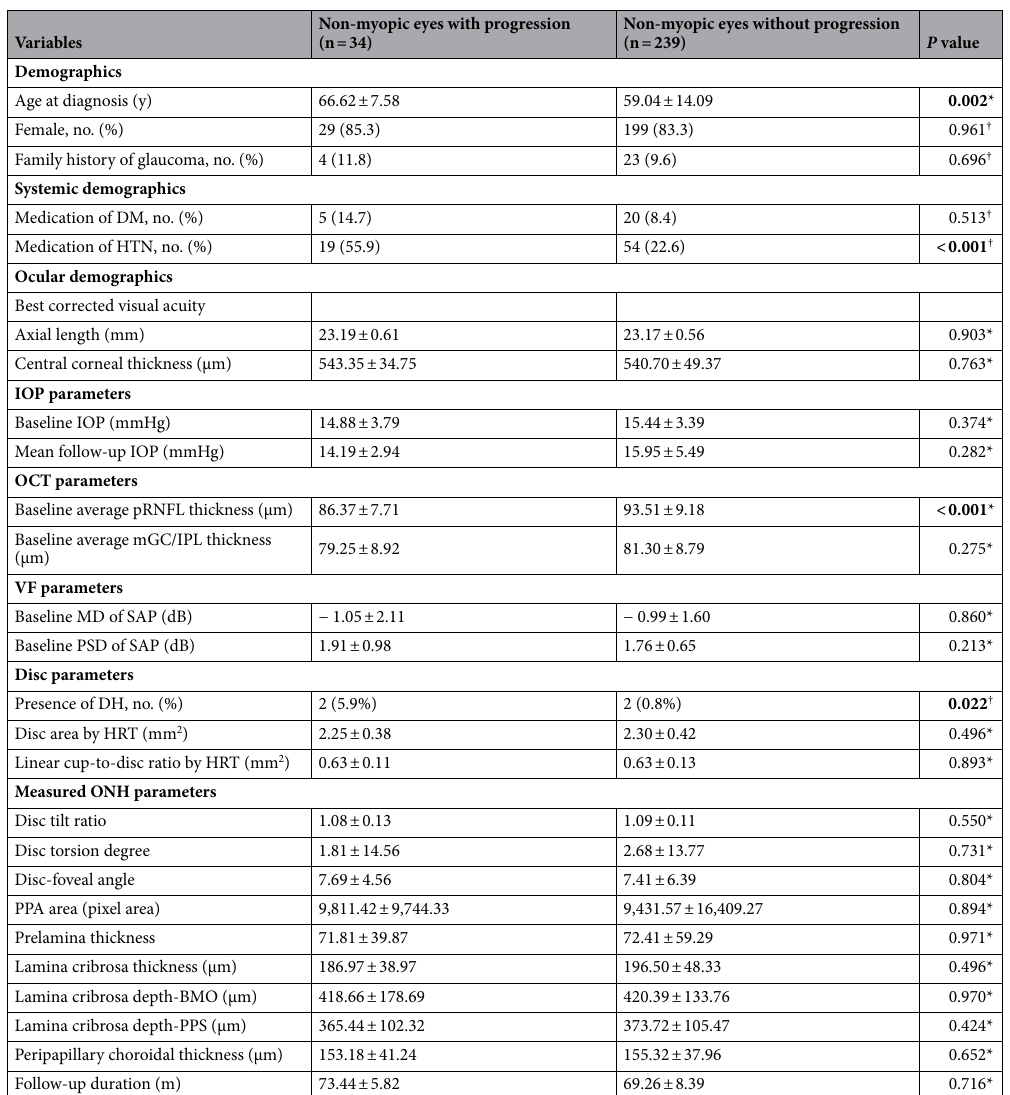
Table 4. Comparison between 273 NTG suspects without myopia that did and did not progress to NTG. DM, diabetes mellitus; HTN, systemic hypertension; OCT, optical coherence tomography; pRNFL, peripapillary retinal nerve fiber layer; mGC-IPL, macular ganglion cell-inner plexiform layer; IOP, intraocular pressure; VF, visual field; MD, mean deviation; PSD, pattern standard deviation; dB, decibel; MD, mean deviation; SAP, standard automated perimetry; DH, disc hemorrhage; HRT, Heidelberg retinal tomograph; ONH, optic nerve head; PPA, peripapillary atrophy; BMO, Bruch’s membrane opening; PPS, peripapillary sclera. Data are mean ± standard deviation unless otherwise indicated. *Student’s t test. † Chi-square test. Data are mean ± standard deviation unless otherwise indicated. Factors with statistical significance are shown in